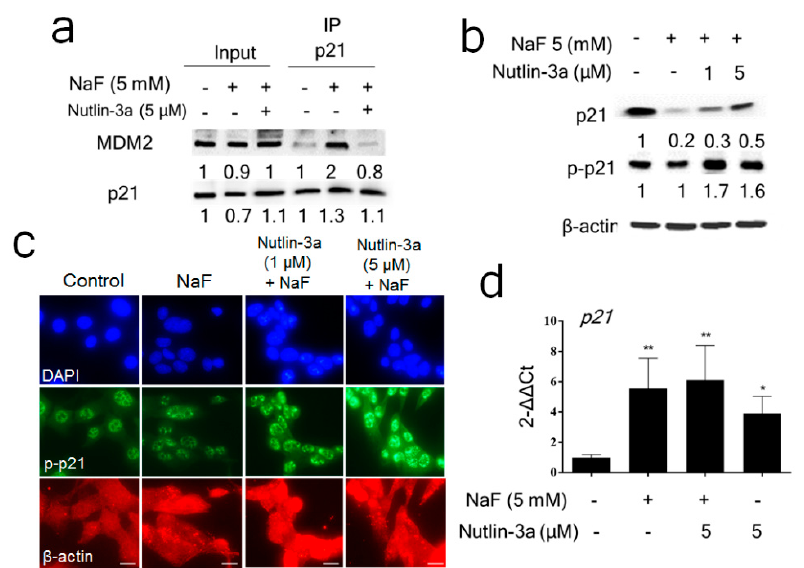
Figure 7. Nutlin-3a reversed the fluoride-mediated p21 protein decrease by increasing p-p21 levels. ( a ) LS8 cells were treated with Nutlin-3a (5 μ M) for 2 h followed by the additional NaF (5 mM) for 6